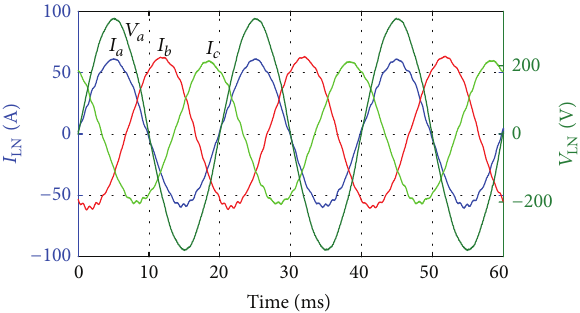
Figure 11: Grid currents and one phase voltage when the inverter supplies to the grid with 30 kW active power at unity power factor.